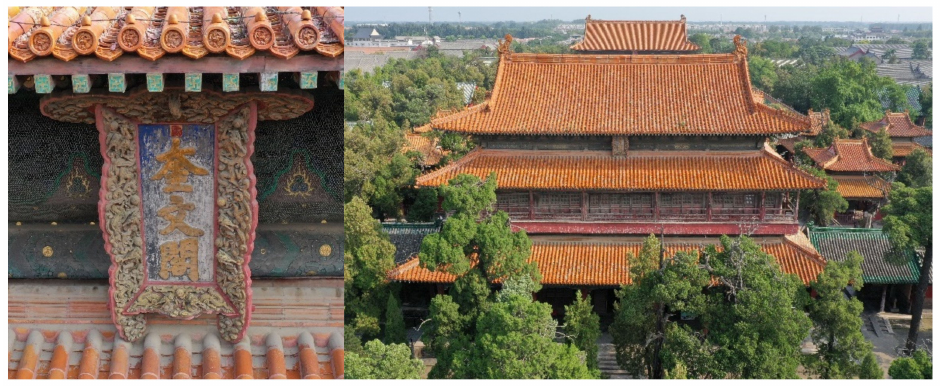
Figure 3. The aerial photo of the Kuiwen